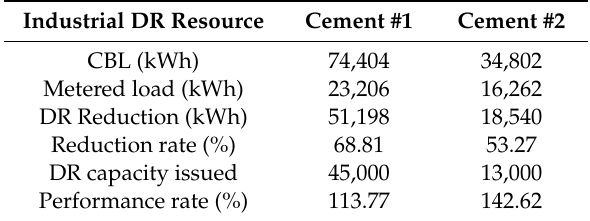
Table 2. Actual DR performance result (DR event: 2016.06.13 18:00–19:00). Industrial DR Resource